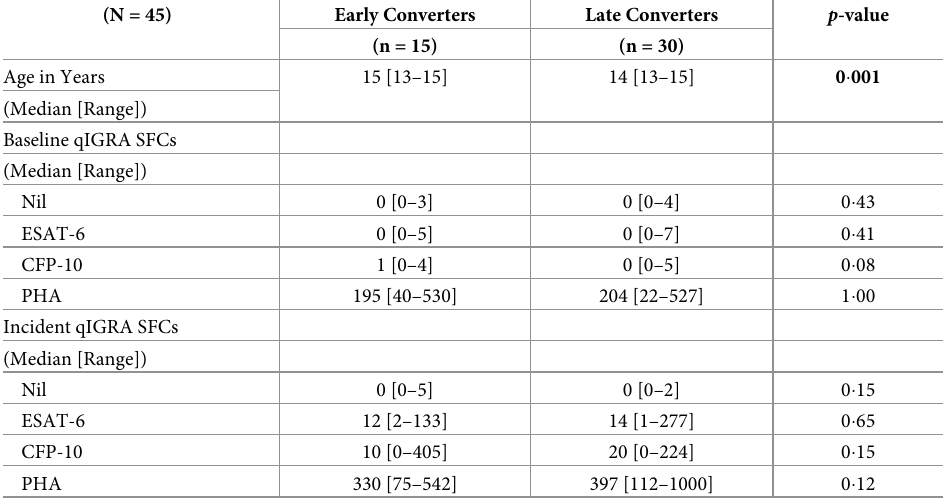
Table 4. Characteristics of IGRA converters based on timing of initial positivity.